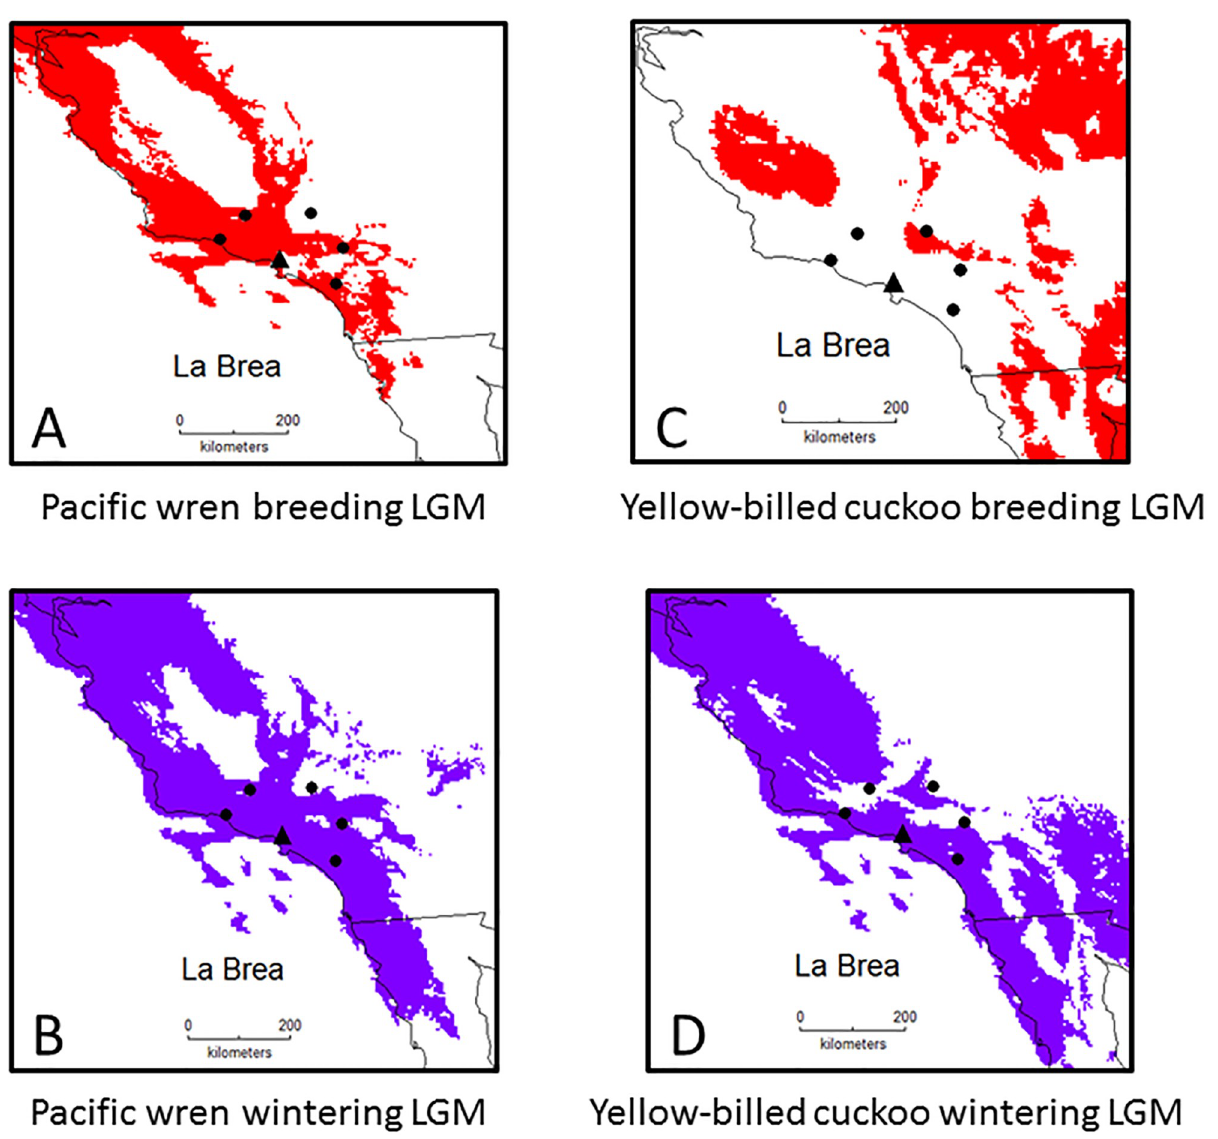
Fig 3. Predicted breeding and wintering distributions for two species suggesting resident status at the